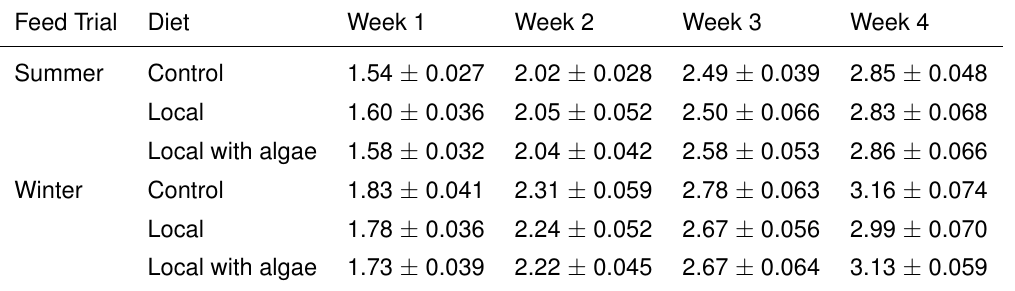
Table 2. Broiler body weights (mean weight in kg and standard error for each diet) for the summer and winter feed trials.